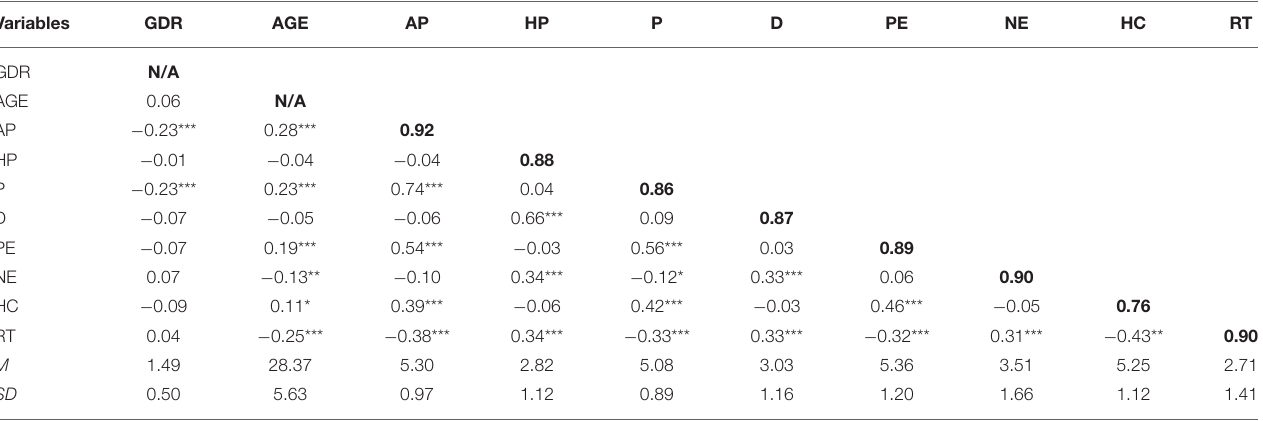
TABLE 2 | Descriptive statistics, correlations and Cronbach’s α